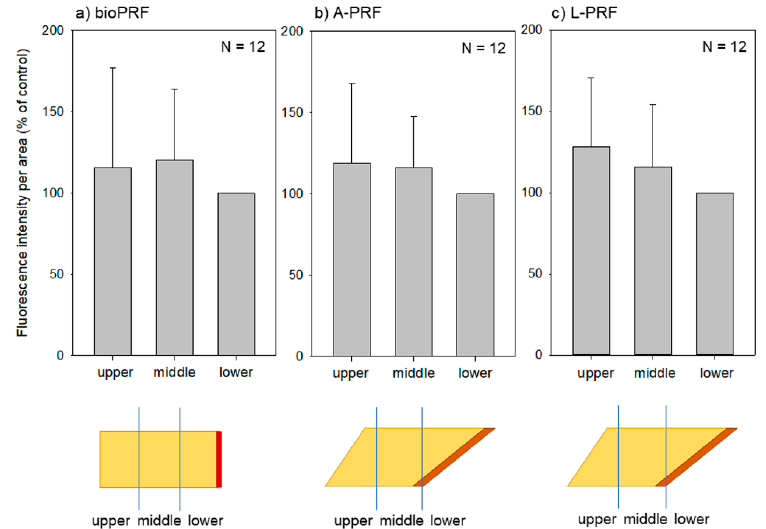
Figure 3. Fluorescence intensities of three regions (upper, middle, and lower) of individual PRF matrices: ( a ) bio-PRF (horizontal, fast spin); ( b ) A-PRF (fixed angle, slow spin); ( c ) L-PRF (fixed angle, fast spin). No significant differences were found among these regions. n = 12.